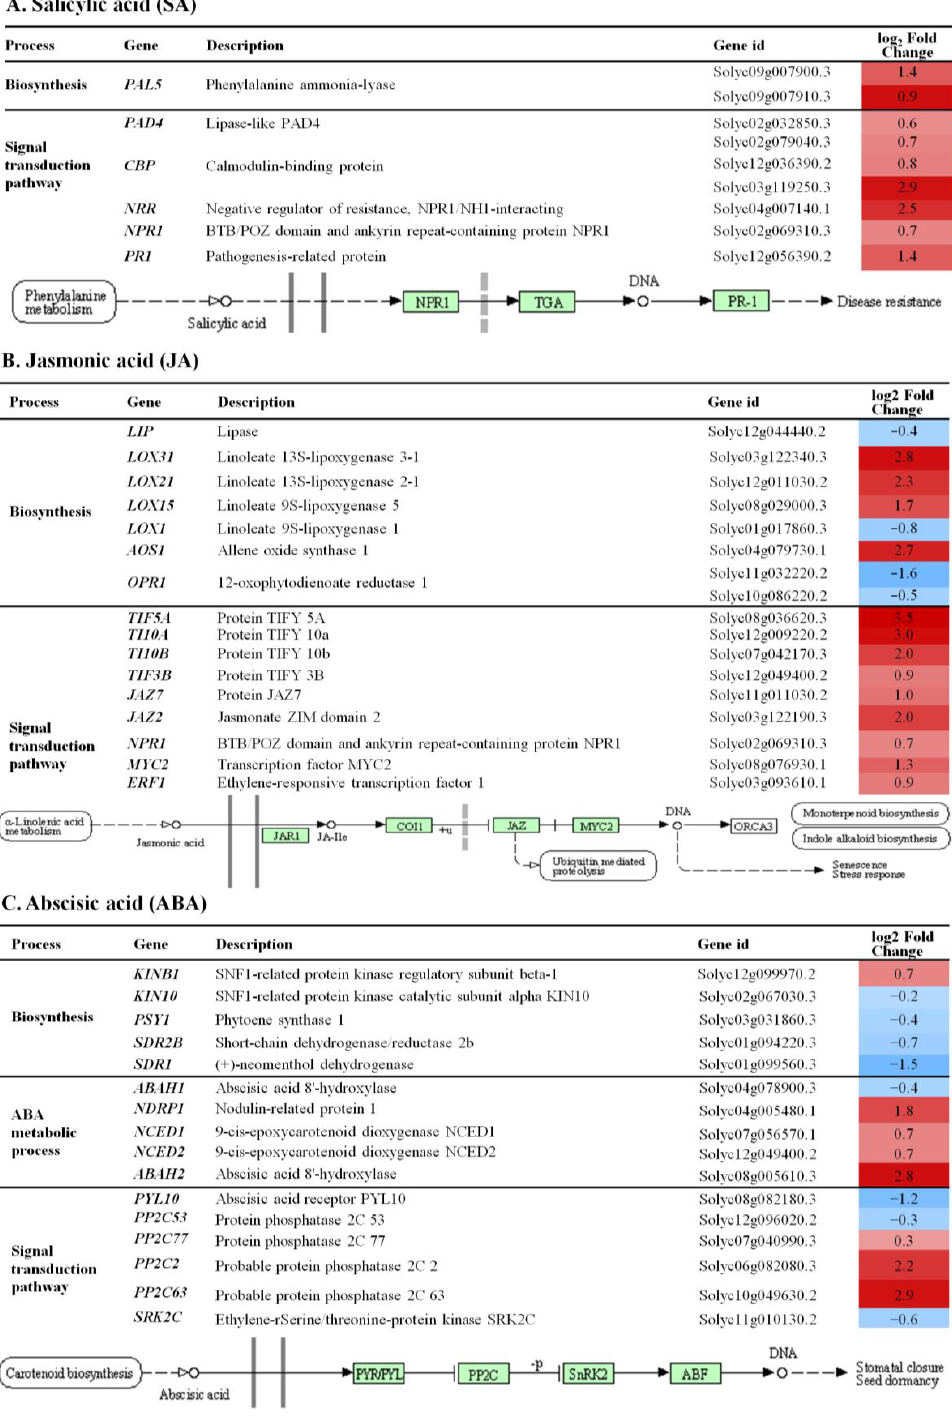
Figure 2. Differentially expressed genes (DEGs) in tomato leaves under Planticine ® treatment involved in biosynthesis and signal transduction pathway of salicylic acid (SA) ( A ), jasmonic acid (JA) ( B ) and abscisic acid (ABA) ( C ). Red and blue colors indicate up- and down-regulation of genes in the pathway, respectively. DEGs involved in plant hormone signal transduction pathway, based on the Kyoto Encyclopedia of Genes and Genomes (KEGG) pathway system, were indicated in green